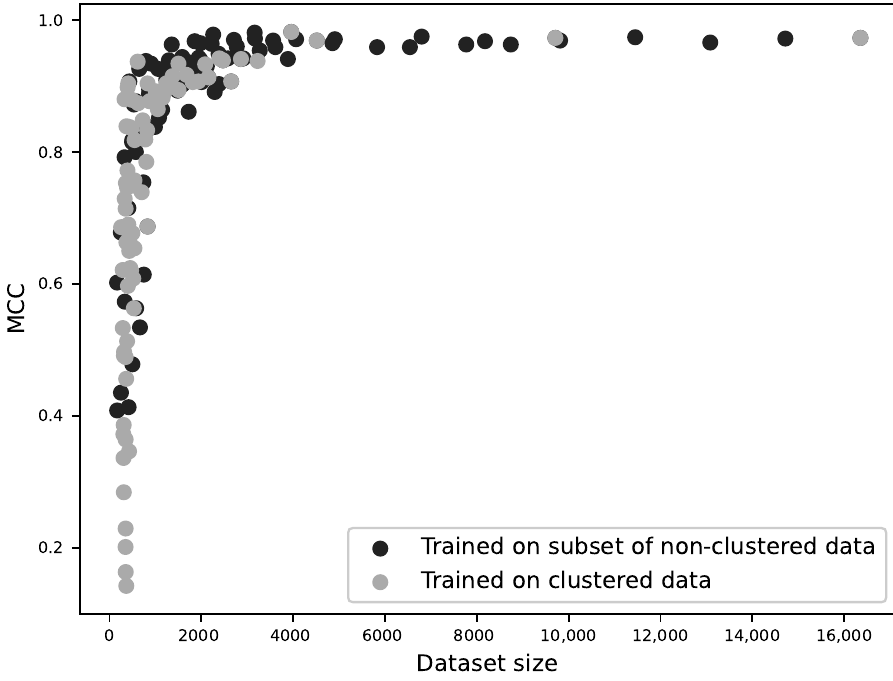
Figure 4. MCC as a function of dataset size for 160 different sequence-based models. For each of the ten zinc-binding site families, 9 classifiers were trained using 20–100% of the original, unclustered data (10 × 9 models); additional classifiers were trained using sequences clustered at 40–100% sequence identity (10 × 7 models). The performance (MCC) is plotted against the size of the training dataset. The two modes of dataset reduction are shown by different shades and it can be seen that the curves are not significantly different. This suggests that homology between training and test sets does not influence a model’s performance; rather, performance is a function of training dataset